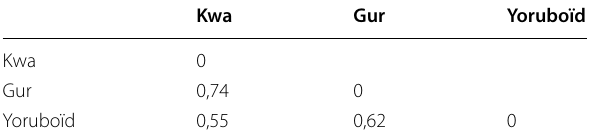
Table 4 Bray–Curtis index (Cn) according to sociolinguistic